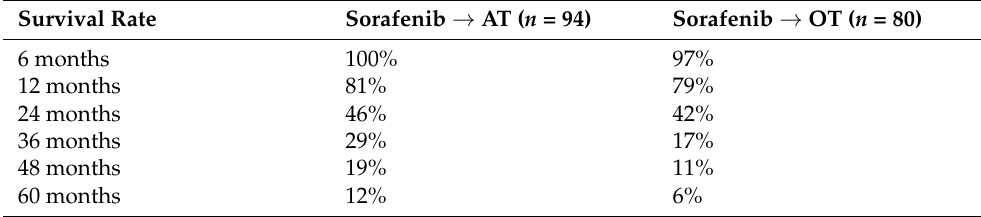
Table 4. Estimated survival rates from the start of